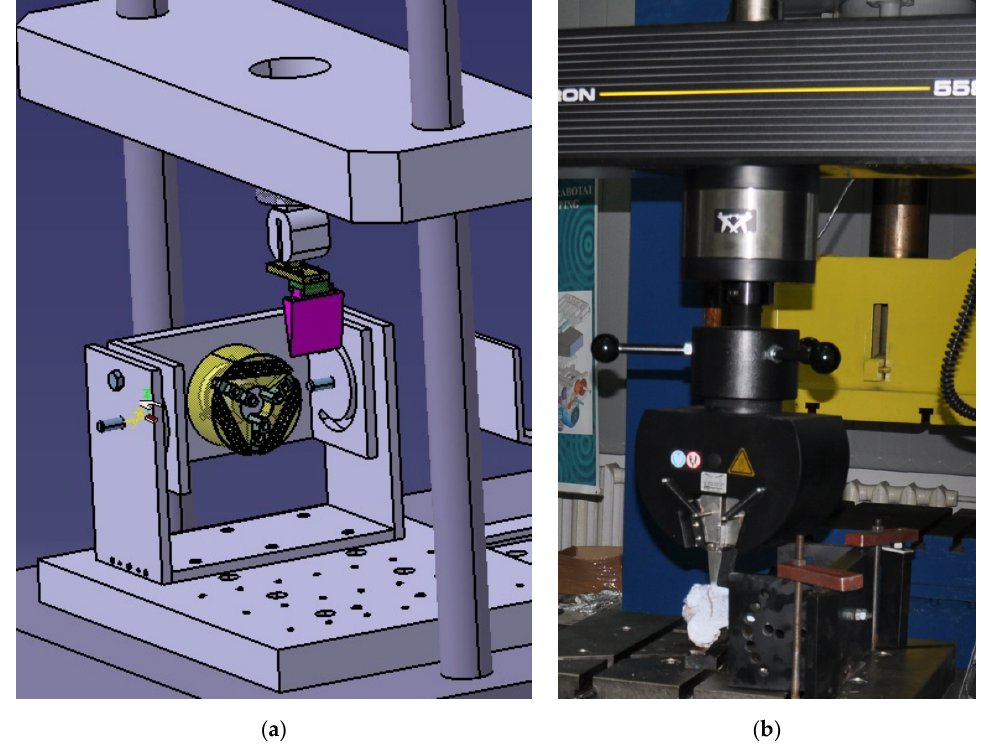
Figure 6. Opening wedge HTO experimental stand: designed and modelled ( a ) and executed and prepared for the experiment ( b ).